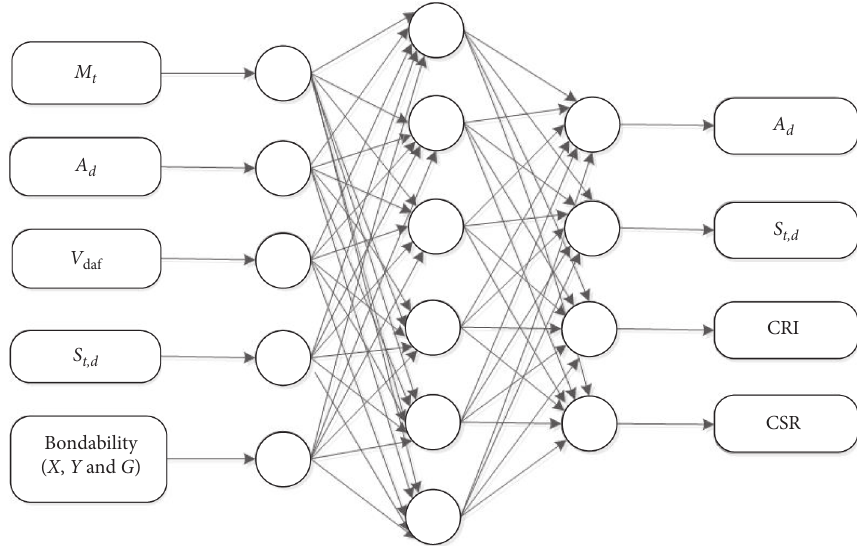
Figure 3: The structure of FB network.